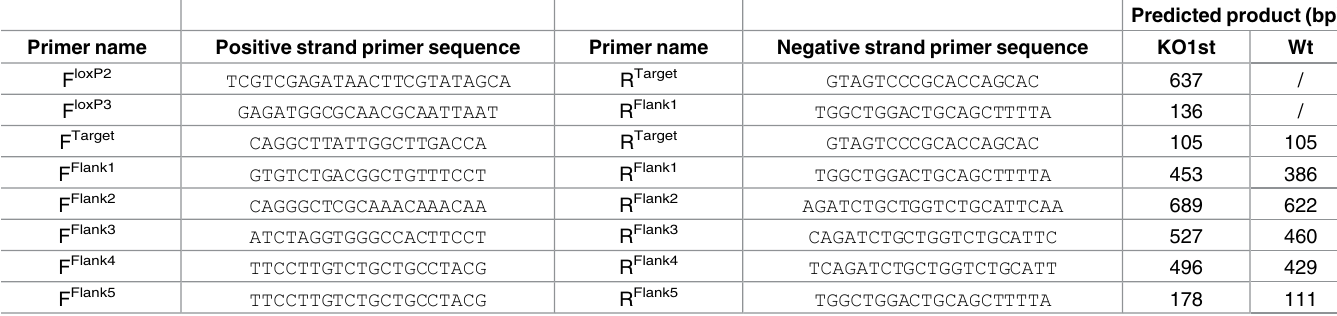
Table 1. Primer names, sequences and predicted PCR product